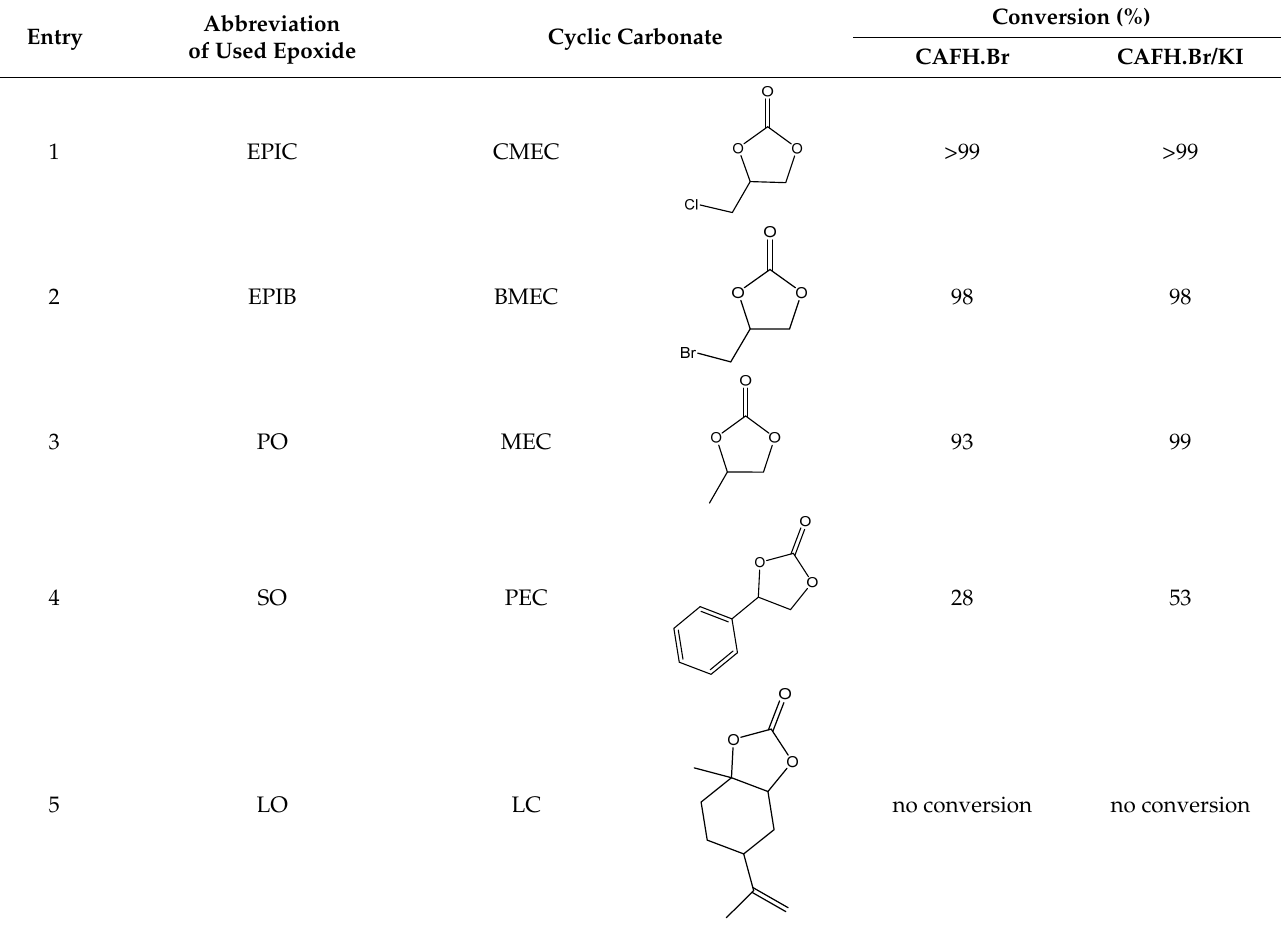
Table 5. Reaction of various epoxides with CO 2 [37].